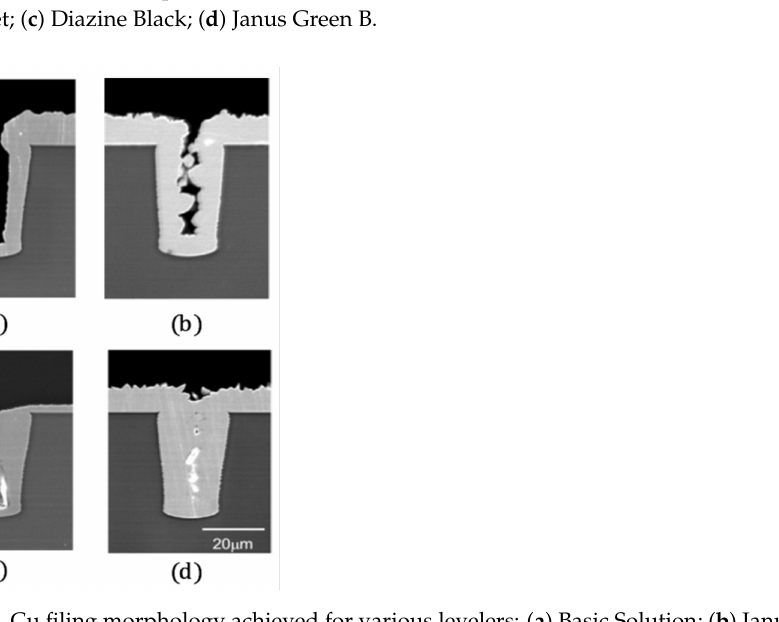
Figure 10. Cu filing morphology achieved for various levelers: ( a ) Basic Solution; ( b ) Janus Green B; ( c ) Diazine Black; ( d ) Methylene Violet.